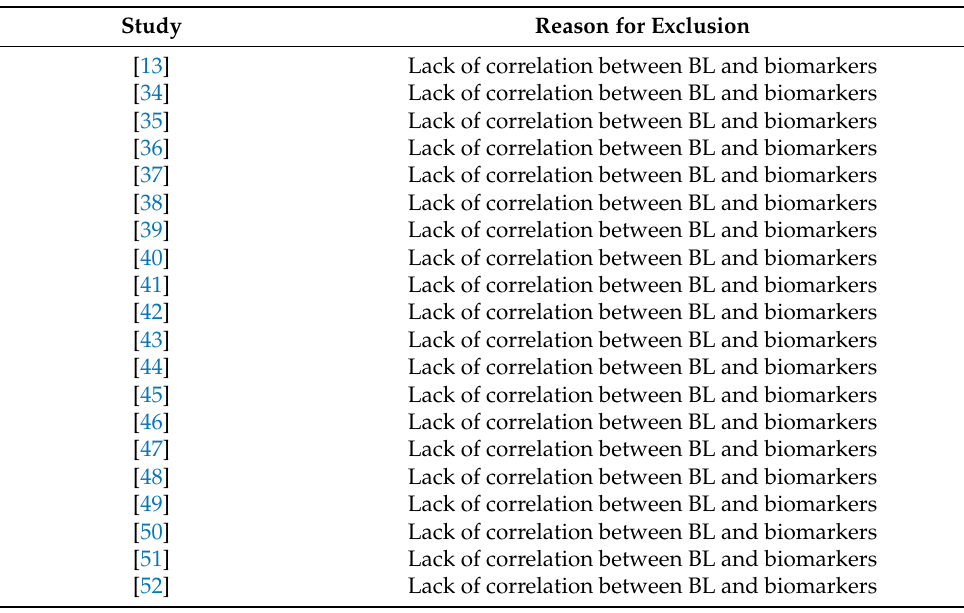
Table A1. Table reporting the 29 excluded studies and reasons for exclusion.